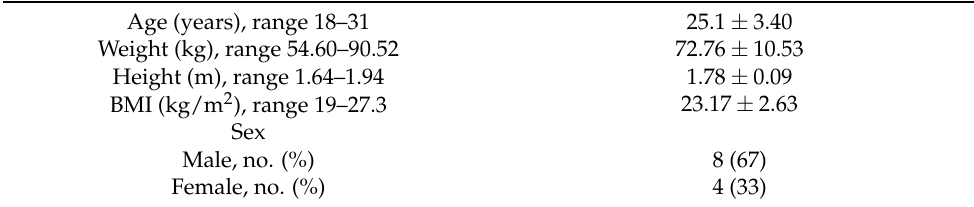
Table 1. Demographics of study participants ( N =